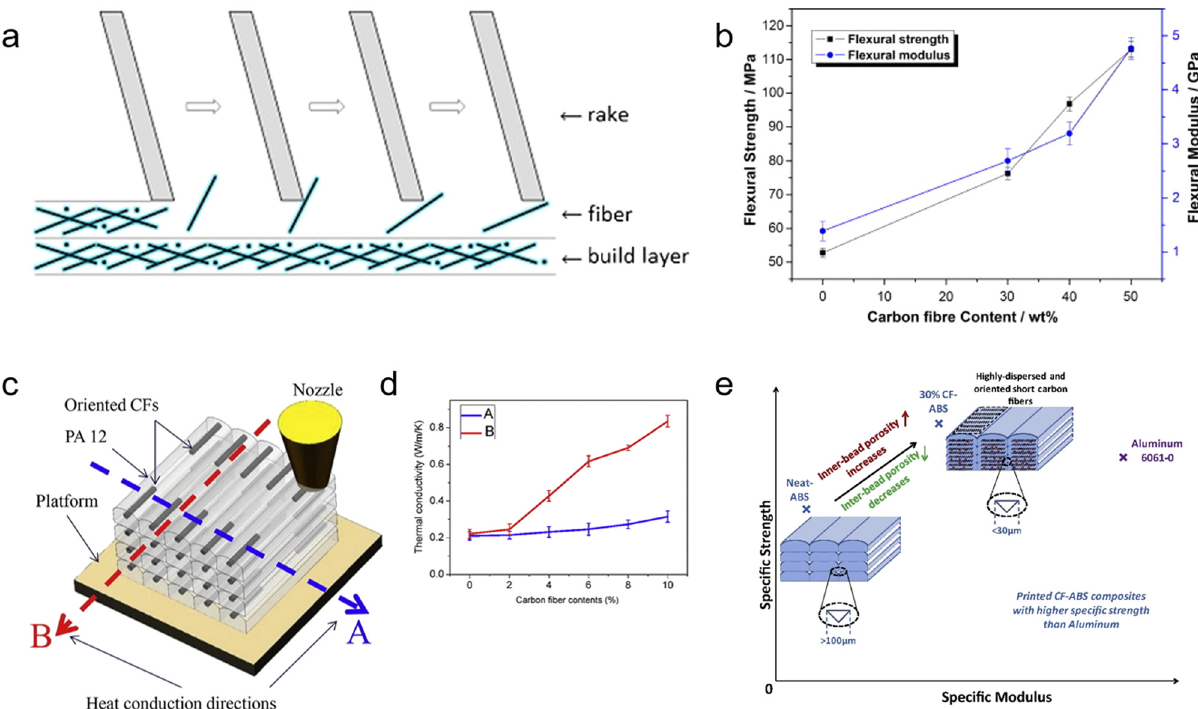
Figure 2: ( a ) Illustration of the rake spreading a powder layer in the build chamber. Reproduced with permission from ref. [ 43 ] , Copyright 2016 Elsevier. ( b ) Variations of the fl exural strength and fl exural modulus of the CF/PA SLS parts with the carbon fi ber content. Reproduced with permission from ref. [ 45 ] , Copyright 2011 Elsevier. ( c ) Schematic of heat - channel in the matrix. ( d ) The thermal conductivity in the matrix of type A ( the blue line ) and type B ( the red line ) . Reproduced with permission from ref. [ 46 ] , Copyright 2018 Elsevier. ( e ) Schematic of 3D - printed CF - reinforced composite by FDM. Reproduced with permission from ref. [ 50 ] , Copyright 2014